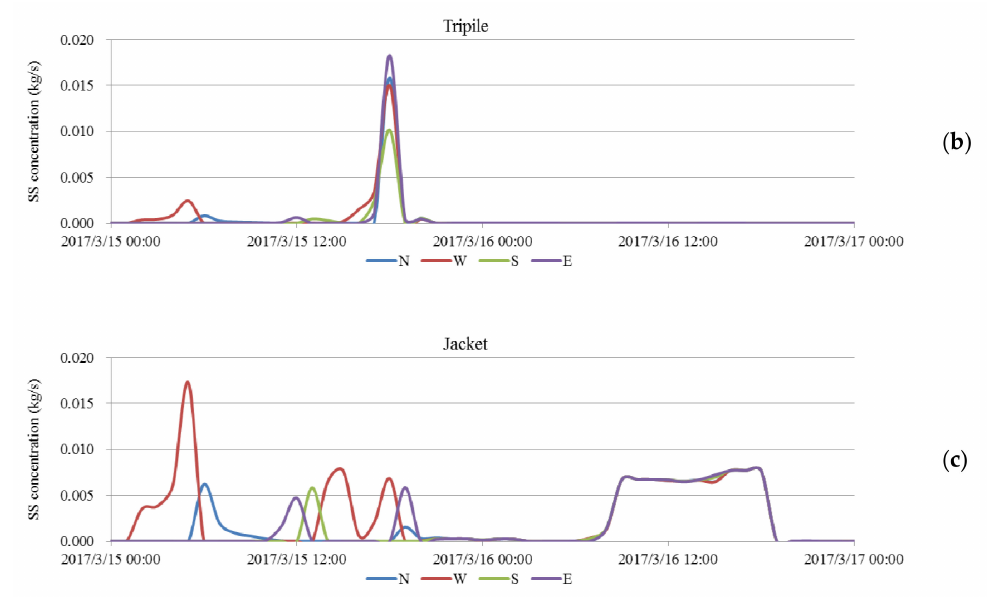
Figure 8. Simulation results of different foundation types: ( a ) monopile; ( b ) tripile; ( c )